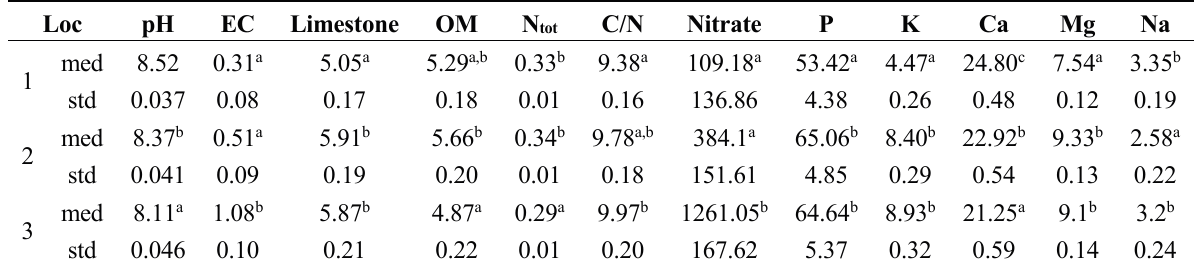
Table 1. Means pH values in water (1:2.5), electrical conductivity 1:5 (EC in dS/m), lime, organic matter (OM, expressed as a %), total nitrogen (N tot , expressed as %), available nitrate (expressed as mg N/kg), Olsen phosphorus (expressed as mg P/kg), extracted cations (expressed as me/100 g): potassium (K), calcium (Ca), magnesium (Mg) and sodium (Na) for the three sampling locations: (1) wet bulb; (2) between lines; (3) between